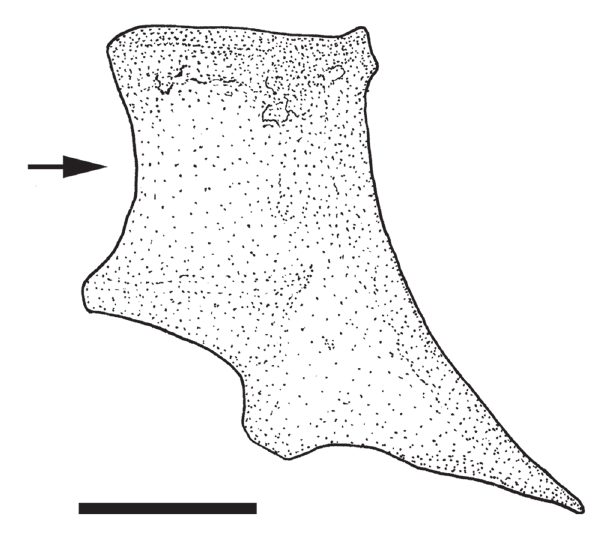
Fig. 16. Autopalatine of Trichomycterus brachykechenos , paratype, UFRGS 16245, 41.9 mm SL, dorsal view. Arrow indicates the concavity of mesial margin. Scale bar = 0.5